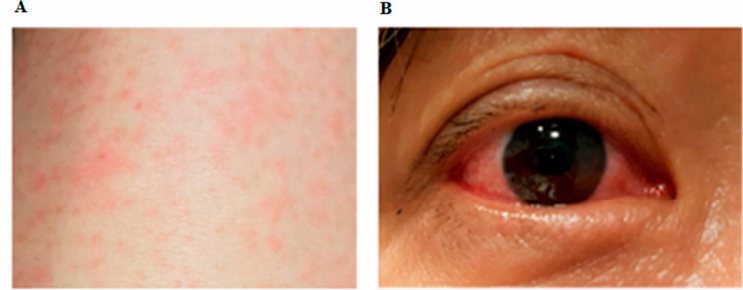
Figure 2. ( A , B ) Clinical images. ( A ) Maculopapular rash on arm; ( B ) Non-purulent conjunctivitis.